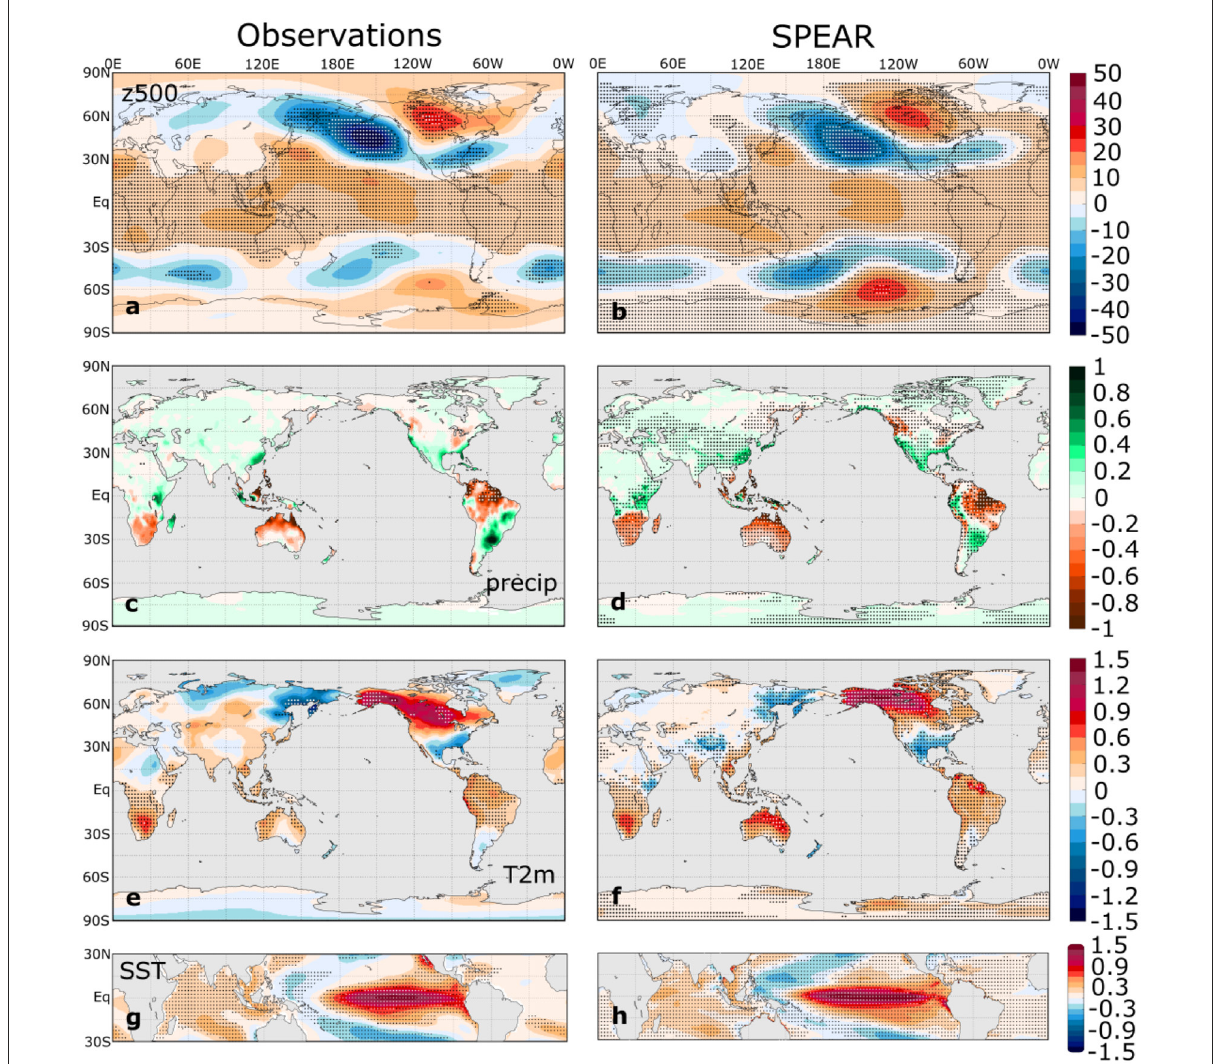
FIGURE1 (Left) observational and (right) ensemble mean SPEAR DJF El Niño composites of (a,b) 500 hPa geopotential height (m), (c,d) precipitation (mm d − 1 ), (e,f) T2m ( ◦ C), and (g,h) SST ( ◦ C) anomalies for the 1951–2020 period. Stippling indicates statistically significant composites that control the false discovery rate at the 10% level based on a two-sided t